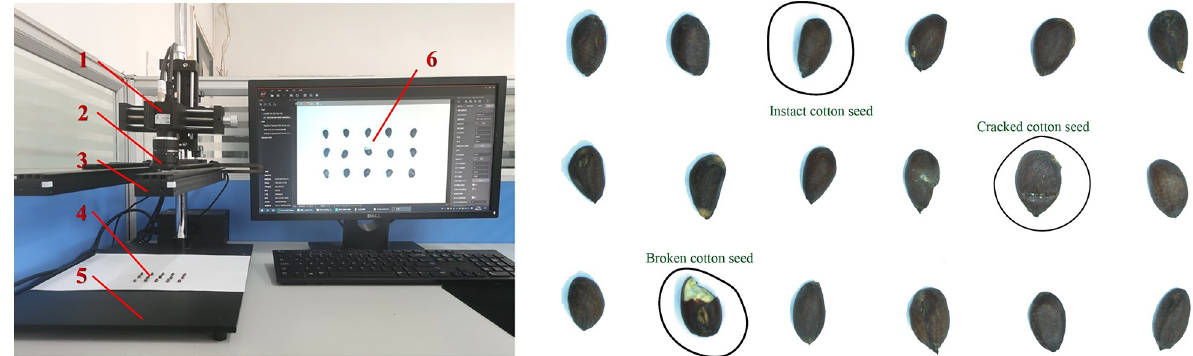
Fig 1. Cotton seed acquisition. (a) Image acquisition system: 1. Camera, 2. Lens, 3. Light-emitting diode (LED) lamps, 4. Cotton seed, 5. Platform, 6. Image monitor. (b) Cotton seed image.